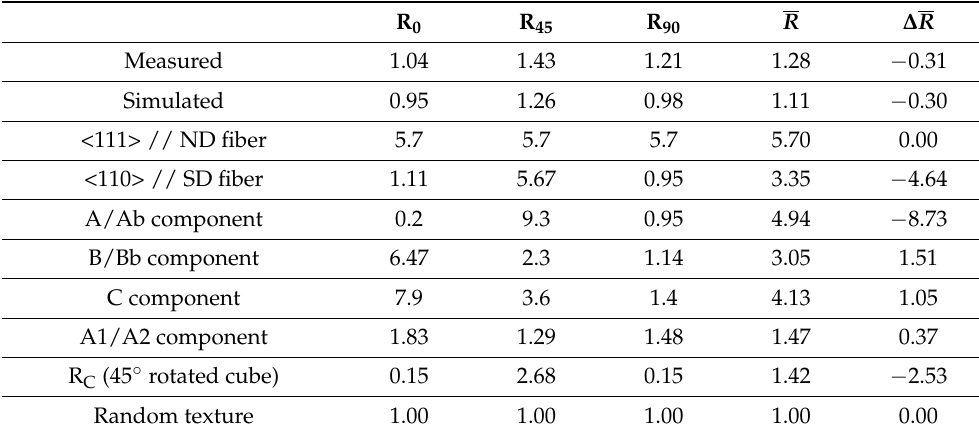
Table 4. Measured and simulated R